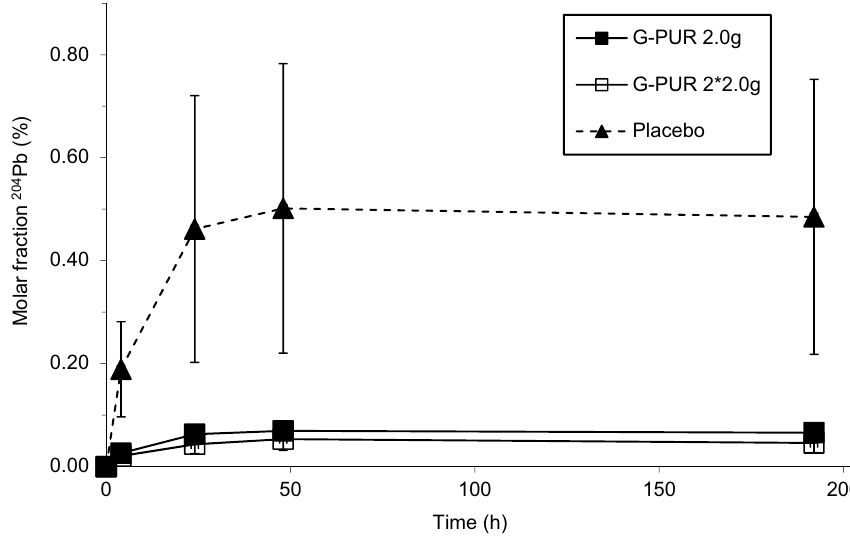
Figure 1. Molar fraction of 204 Pb of total blood lead (% of individual total Pb at each time point, normalized for haematocrit and body mass index) after single oral intake of 2.5 µg 204 Pb with purified clinoptilolite (G-PUR) at 2.0 g, 2 * 2.0 g, or placebo. Means ± SD are indicated, n = 14 per group.